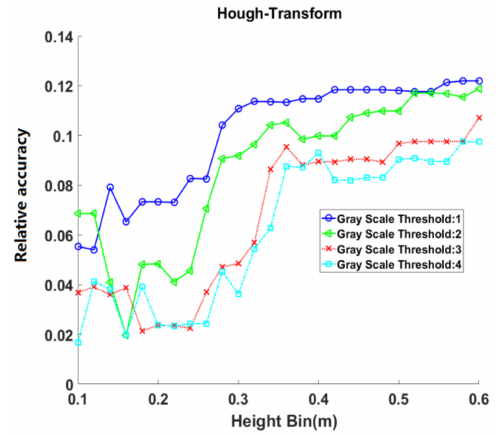
Figure 8. The relative accuracy of Hough-Transform under different height bins and gray scale thresholds in multi-scan mode of the natural secondary